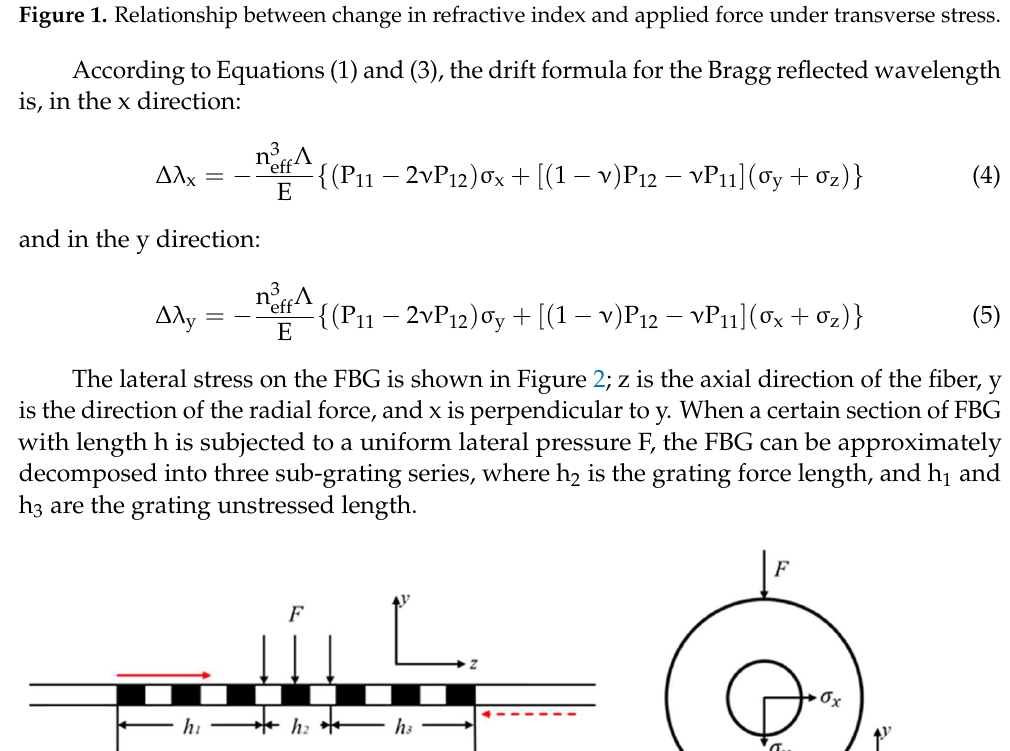
Figure 2. Schematic diagram of lateral stress: axial and cross-section of the grating.